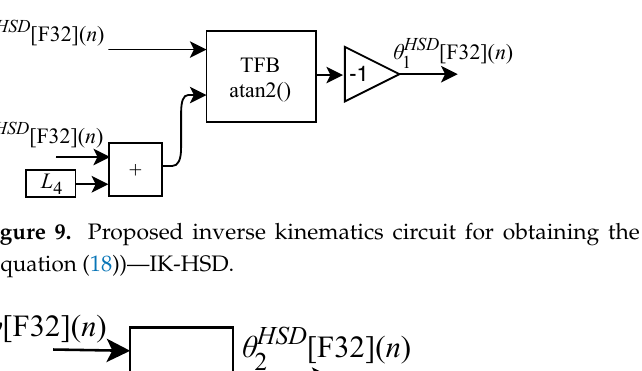
Figure 10. Proposed inverse kinematics circuit for obtaining the θ HSD (Equation